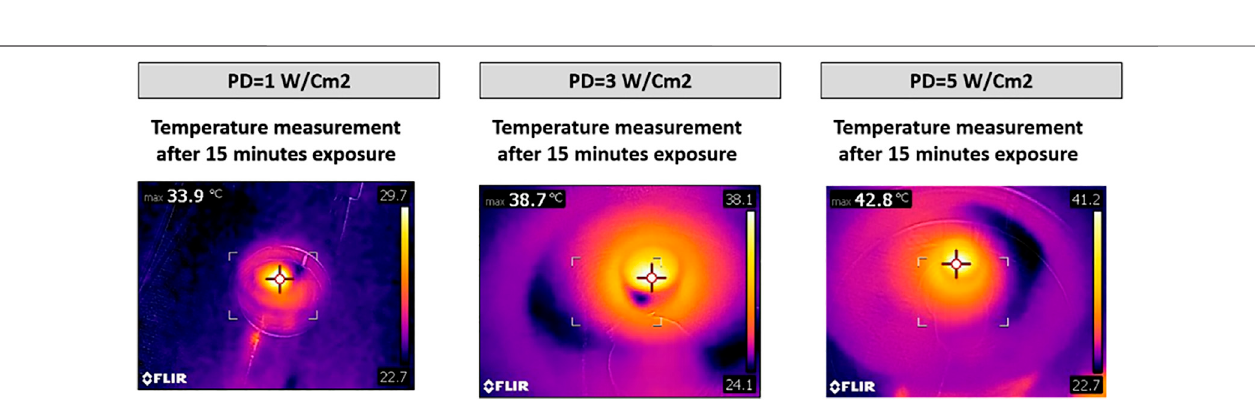
FIGURE 10 | Temperature measurement for cells treated with 200 µg/ml MXene then exposed to laser at different PDs for 15 min.